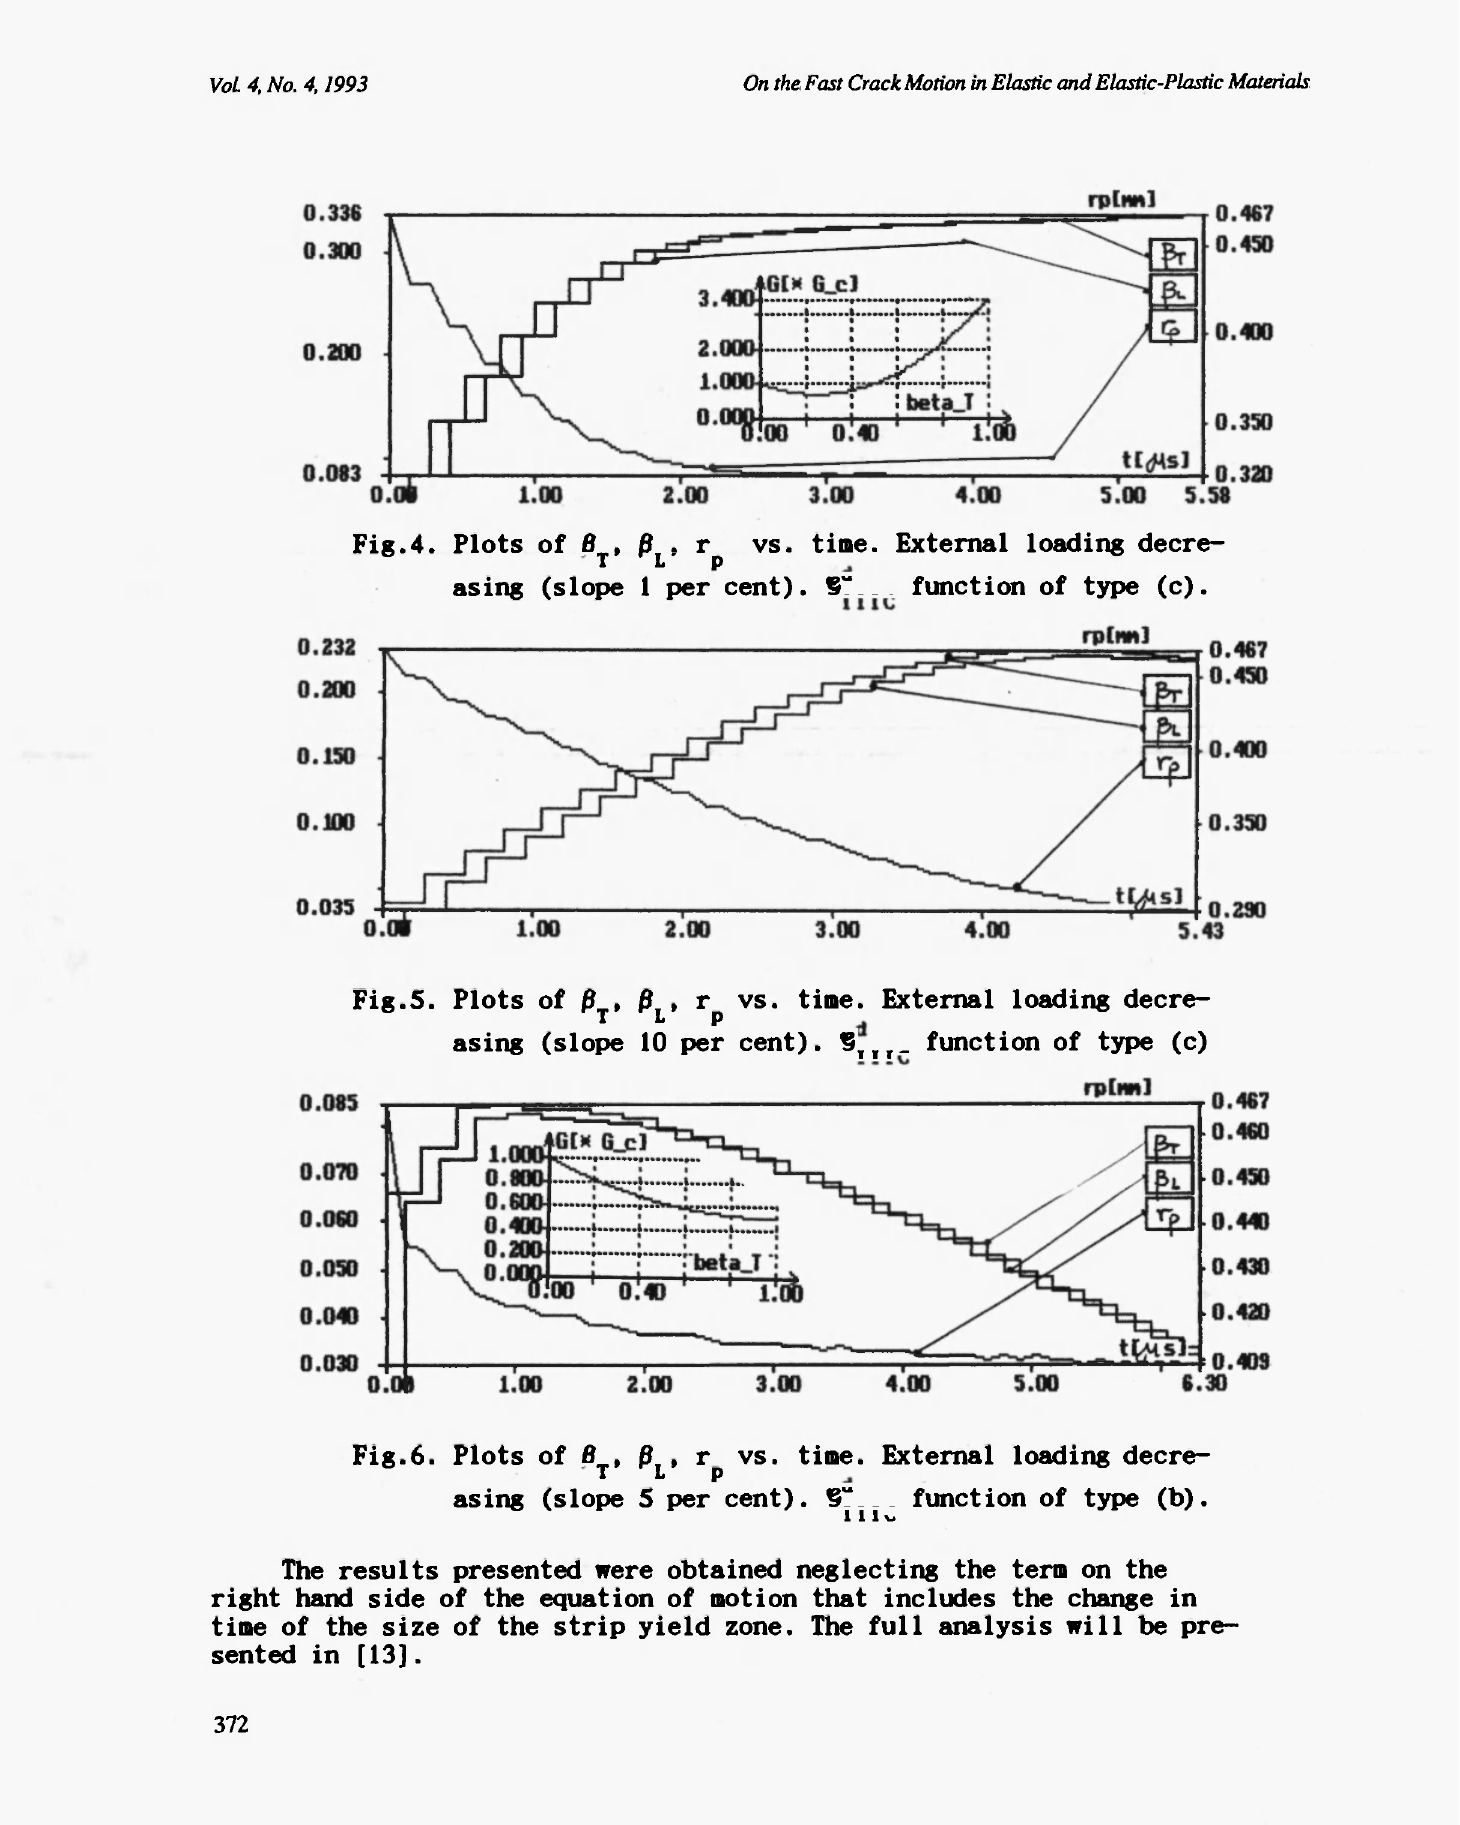
Fig.6. Plots of β , ß,, r vs. time. External loading decre- T L ρ asing (slope 5 per cent), β function of type (b). 1 1 1